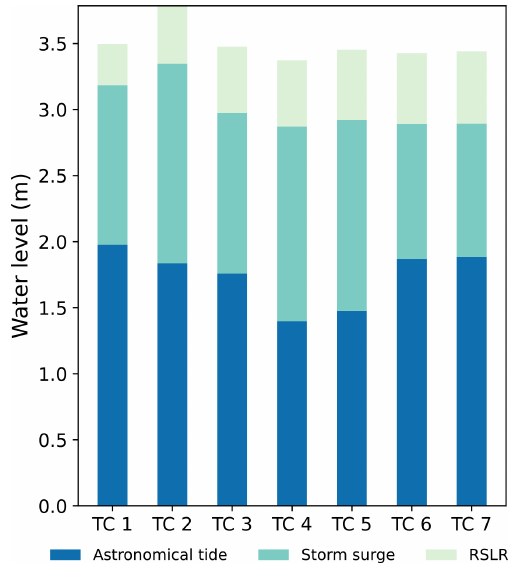
Figure 7. The contributions of the storm surge, the astronomical tide, and the RSLR to the peak water level (cases are samples with a joint return period of greater than 10